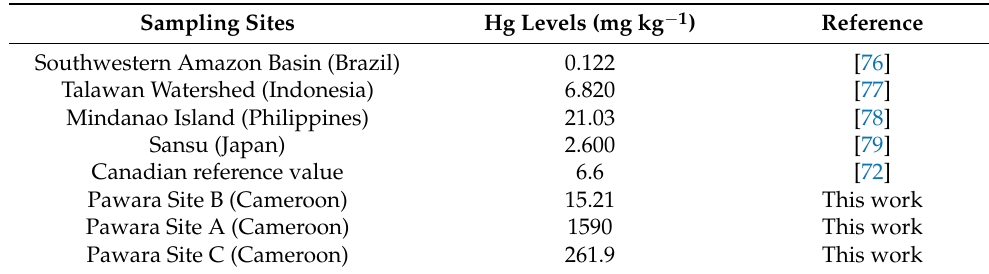
Table 6. Comparing Hg concentration in soils from mining sites in the Pawara area and some previous works around the world